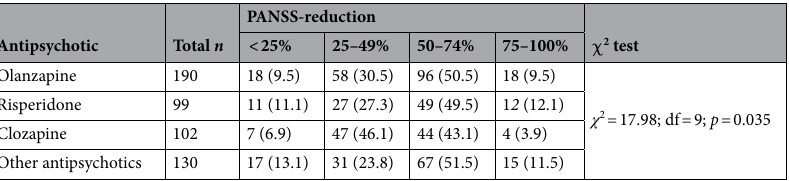
Table 2. PANSS-derived response rates in patients with schizophrenia after 8 weeks of treatment with olanzapine, risperidone, clozapine or other antipsychotics. Frequencies (%) are shown in parenthesis. n number of subjects, PANSS positive and negative syndrome